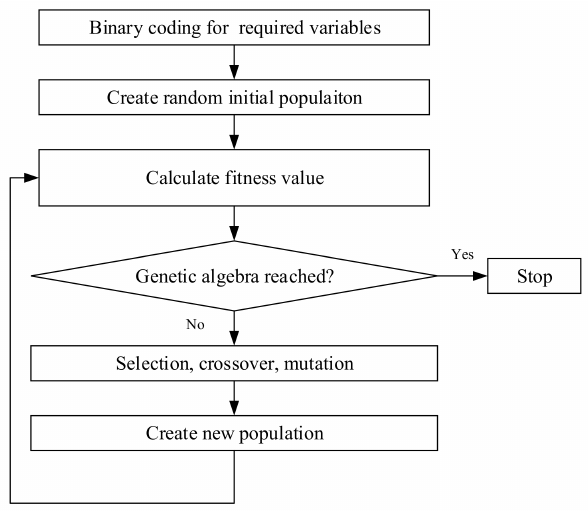
Figure 4. Working mechanism flowchart of a genetic algorithm